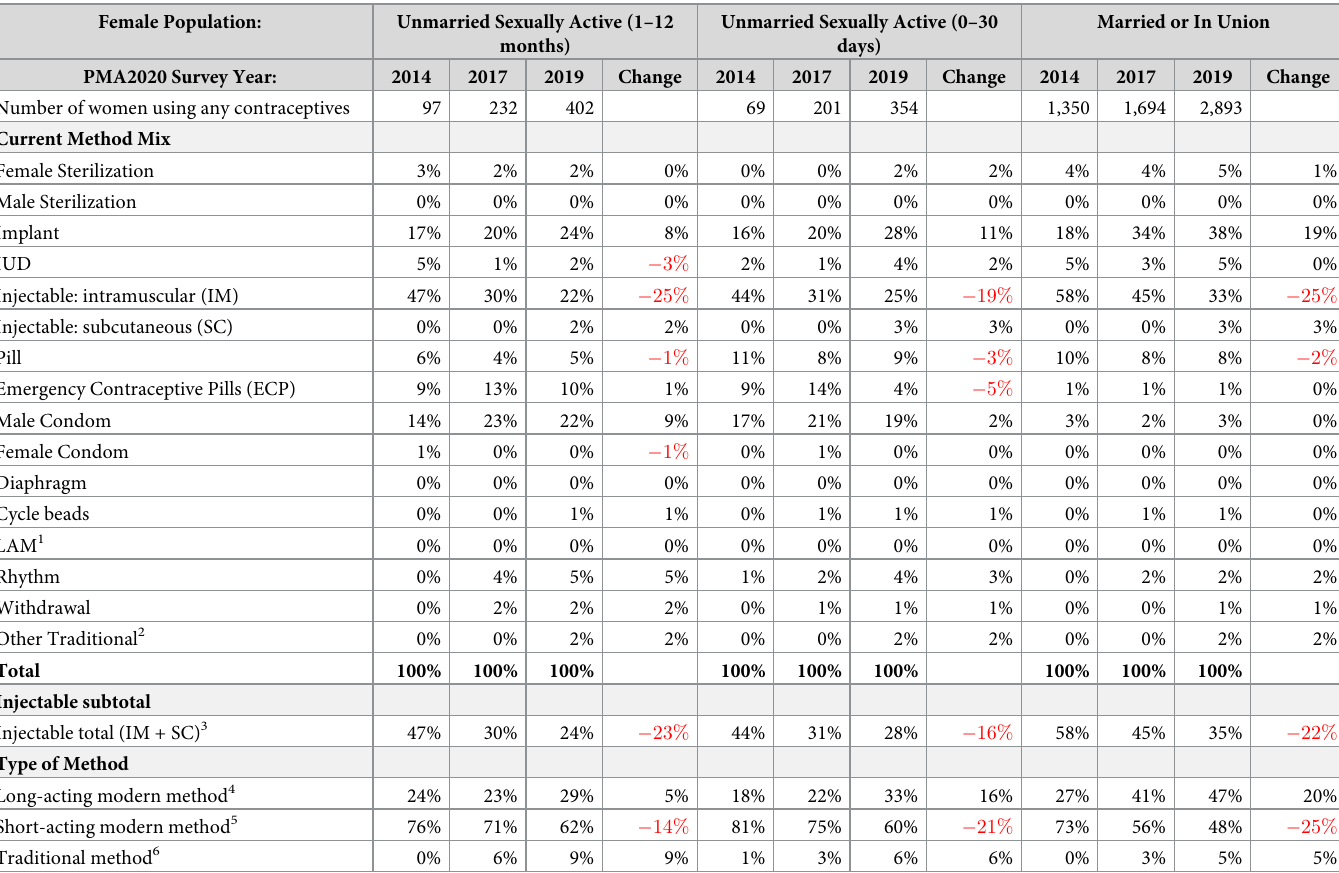
Table 3. Contraceptive method mix by female subgroup, PMA/Kenya (2014, 2017, 2019). Female